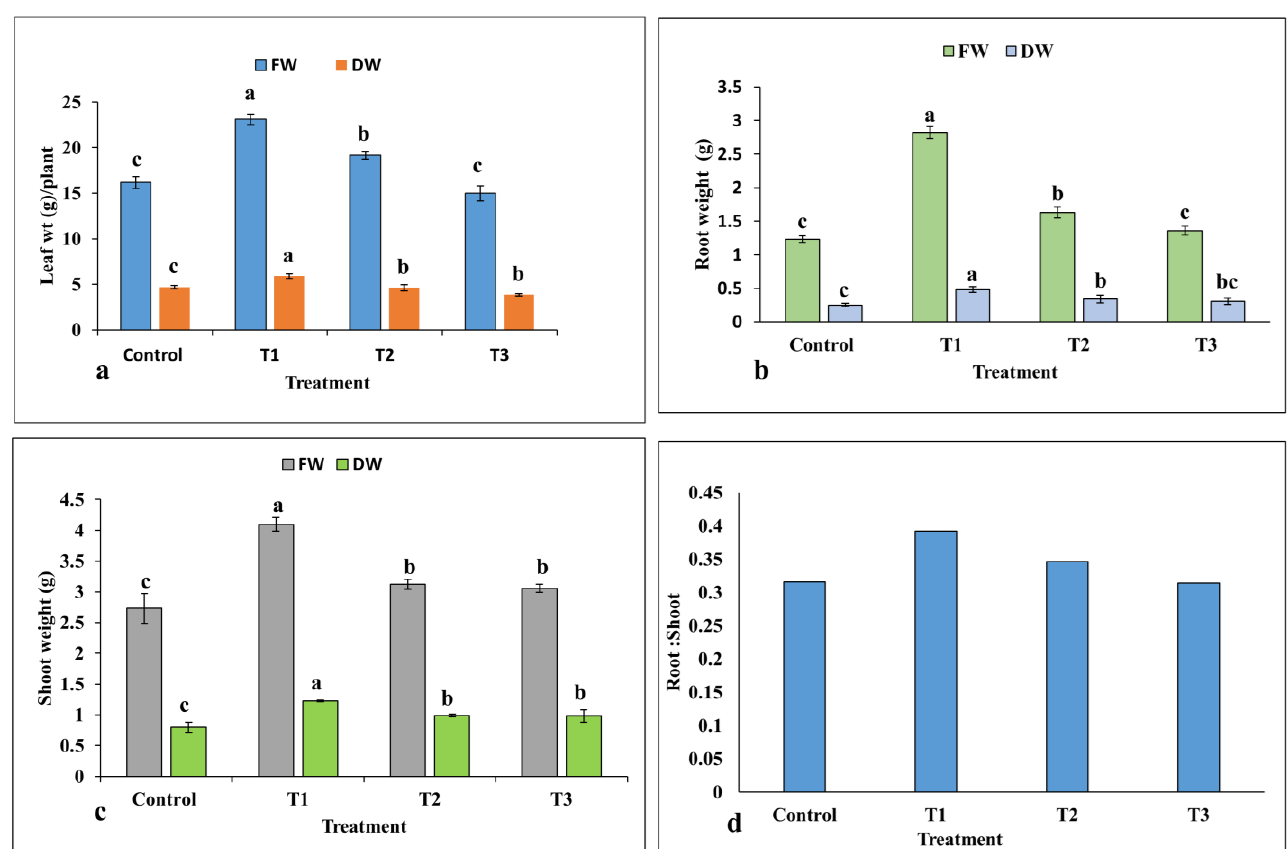
Figure 6. Effects of ZnO-NPs on fresh and dry weights of plant parts: ( a ) leaves; ( b ) roots; ( c ) shoots; ( d ) root to shoot ratio per plant ( n = 3). Treatments including control (0 mg/L, ZnO-NPs); T1 (10 mg/L, ZnO-NPs); T2 (20 mg/L, ZnO-NPs) and T3 (40 mg/L, ZnO-NPs). Different letters represent the significant values according to the test of Duncan at level p < 0.05.